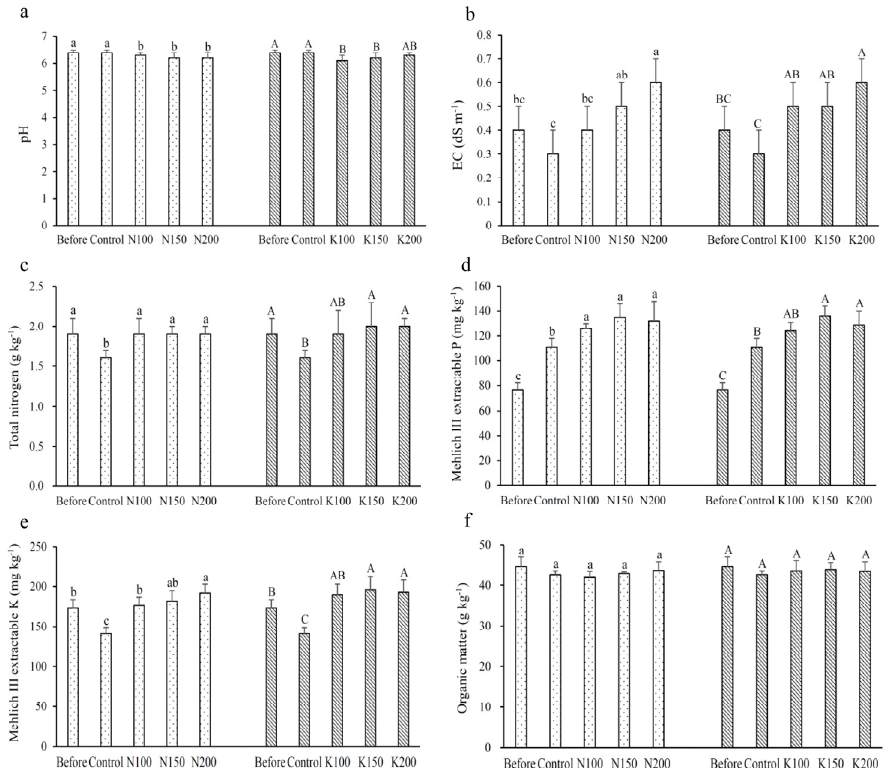
Figure 1. Chemical properties of soil before and after field experiment: ( a ) pH; ( b ) EC; ( c ) Total nitrogen; ( d ) Mehlich-III-extractable phosphorus; ( e ) Mehlich-III-extractable potassium; ( f ) Organic matter. Values are mean ± standard deviation ( n = 4). The bars with different letters within the same fertilizer treatment (N treatments: Control, N100, N150 and N200; K treatments: Control, K100, K150 and K200) are significantly different ( p < 0.05, LSD tests). EC: Electrical conductivity of saturated extract.